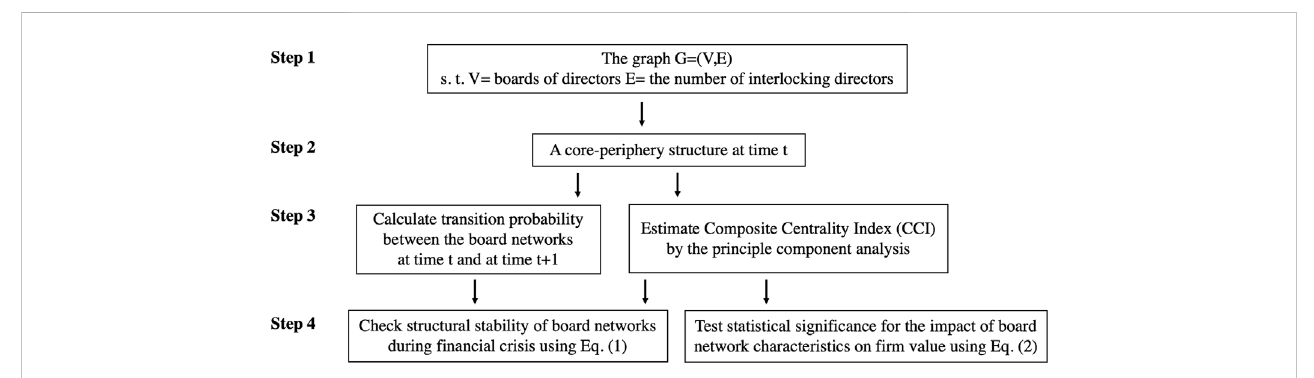
Table 2, we calculate modularity by a community detection algorithm to analyze the structure of the networks. Modularity